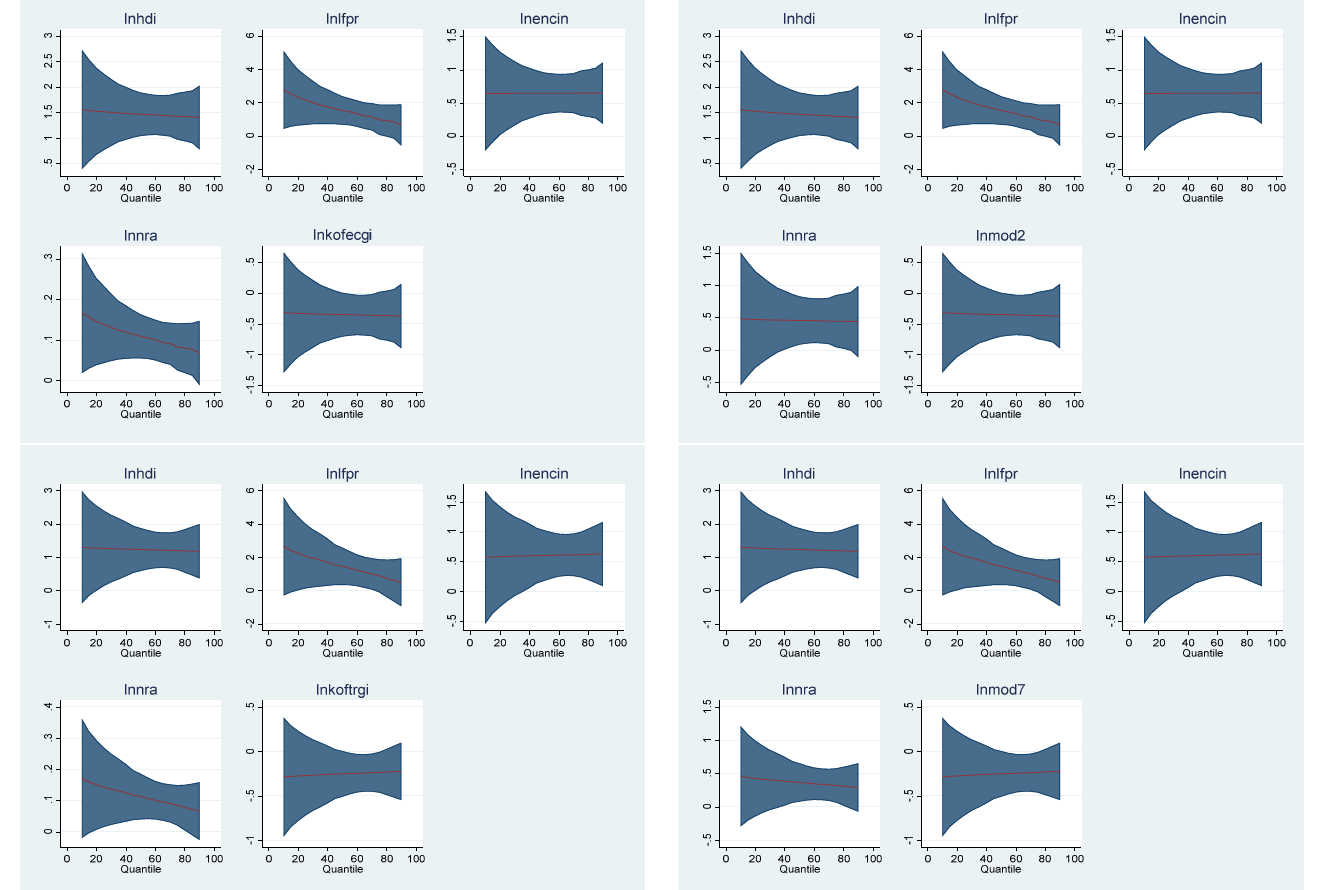
Figure A1. Plotting coefficients of quantile regression. Note: lnhdi = LHDI, lnlfpr = LPRFL, lnencoin = LEIND, lnnra = LNR, lnkofecgi = LEGL, lnkoftrgi = LTGL, lnmod2 = LMod1, lnmod7 = LMod2.